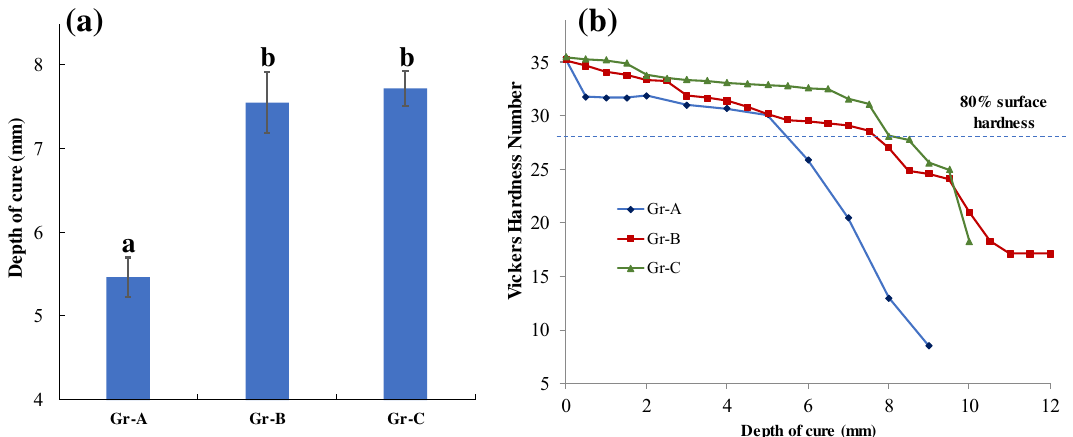
Figure 2. ( a ) Mean and standard deviation of the depth of cure. Groups with the same alphabets are not significantly different from each other (p > 0.05); ( b ) variation of Vickers hardness number (VHN) along the depth of the sample from the curing surface. Horizontal dotted line represents 80% of surface